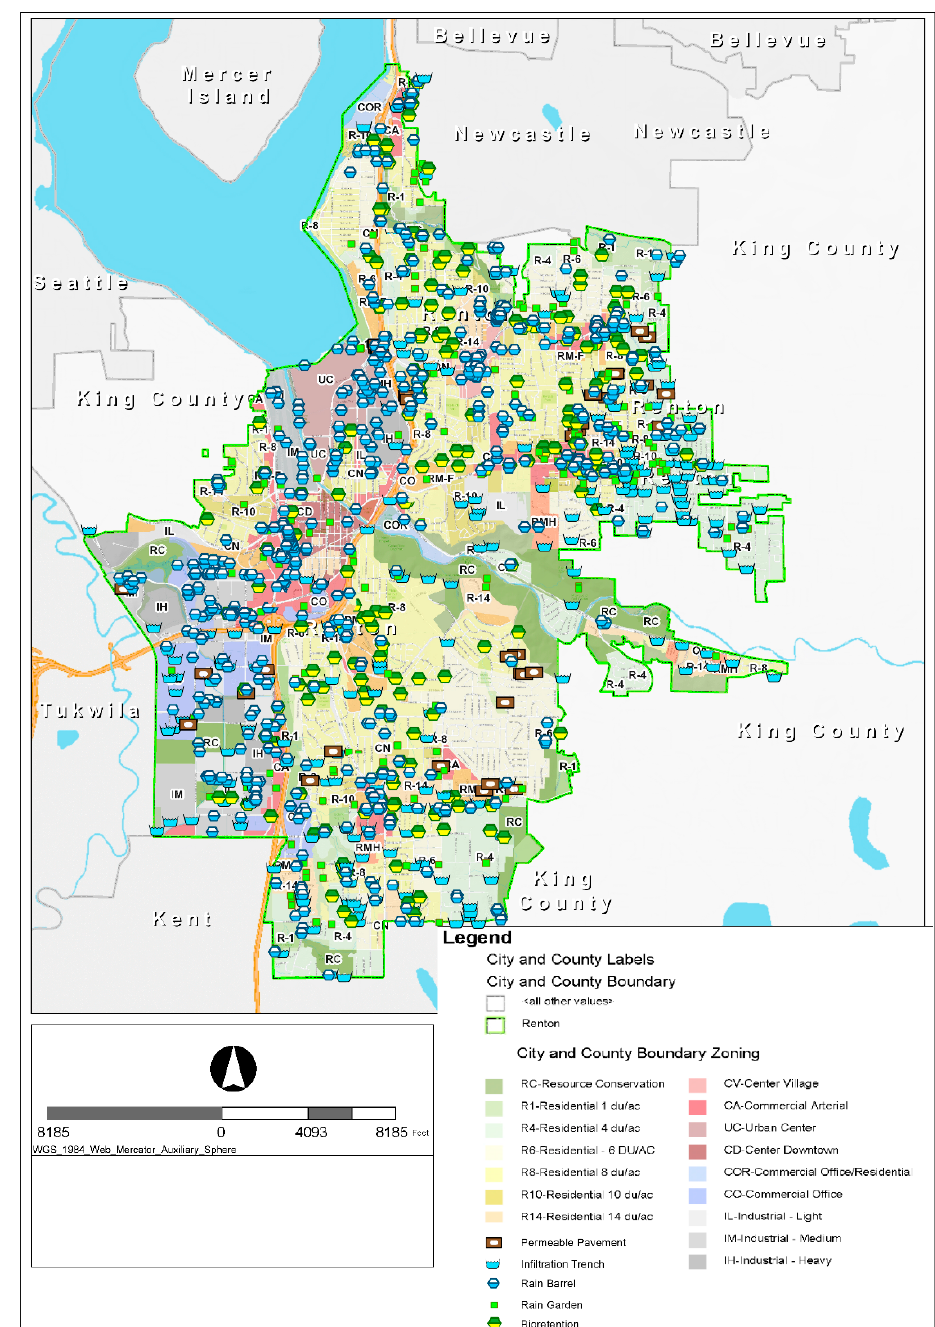
Figure 5. Locations of the proposed LIDs and distributions of the soil types.